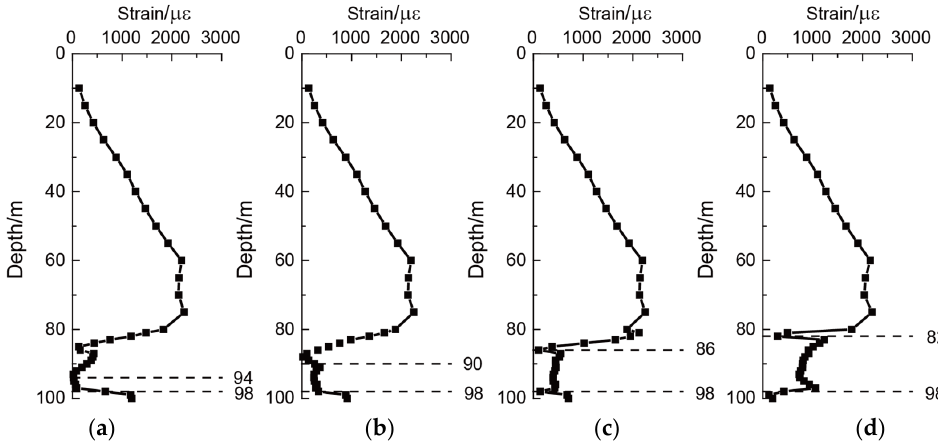
Figure 4. The results of the rock-socketed piles with different heights of the karst cave. ( a ) Height 4 m, ( b ) height 8 m, ( c ) height 12 m, ( d ) height 16 m.